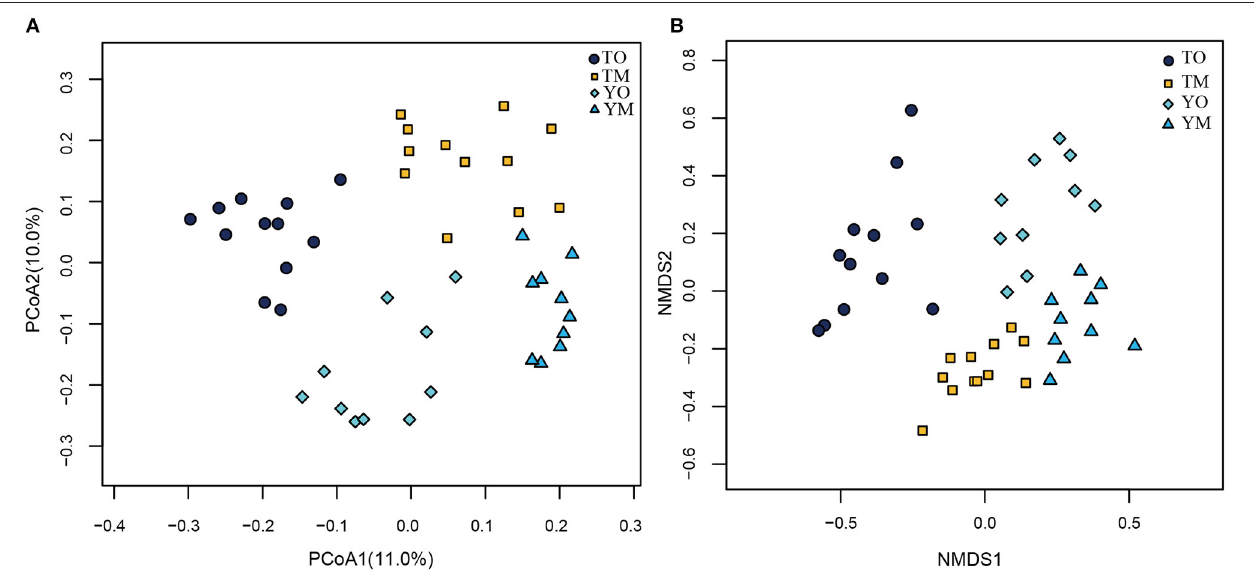
FIGURE 5 | Principal coordinate analysis (PCoA) (A) and NMDS plot (B) on effect of soil horizon on fungal communities at the O and M soil horizons. TO represents the O horizon at Tiantangzhai Nature Reserve. TM represents the M horizon at Tiantangzhai Nature Reserve. YO represents the O horizon at Yaoluoping Nature Reserve. YM represents the M horizon at Yaoluoping Nature Reserve.